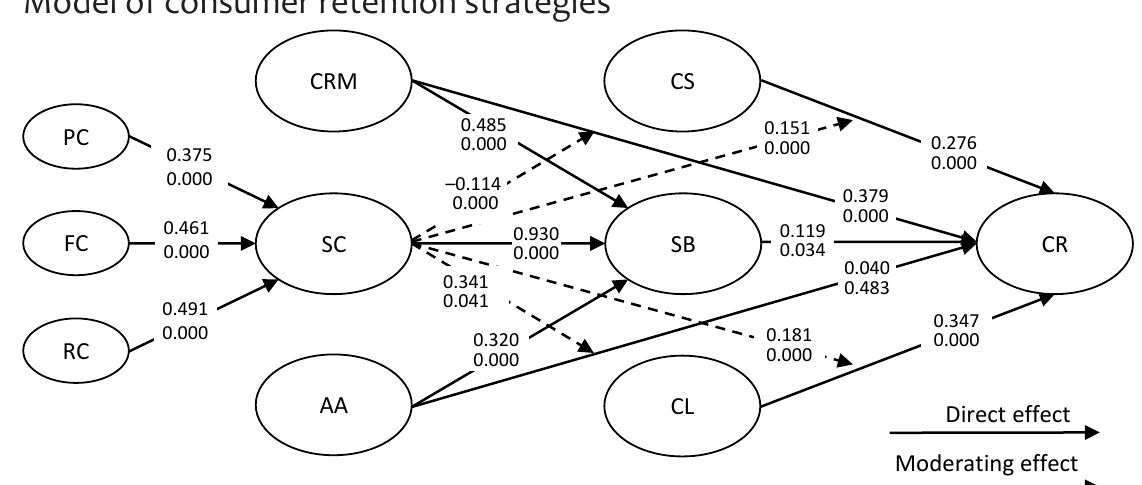
Figure 2. Structured model of a determinant of consumer retention